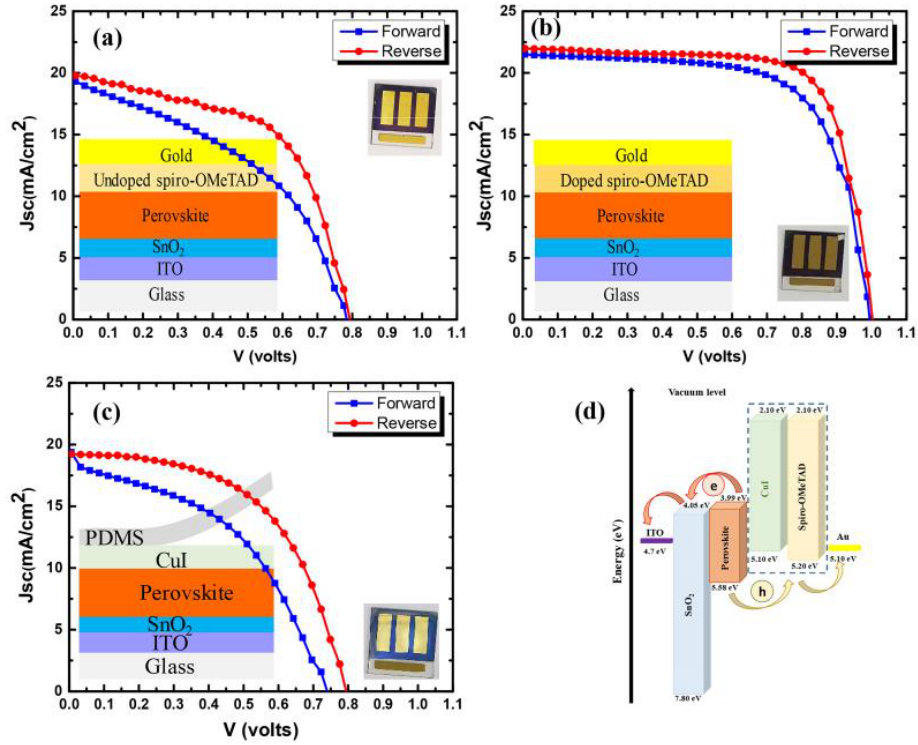
Figure 6. J–V curves for devices fabricated with different HTLs: ( a ) undoped spiro-OMeTAD, ( b ) doped spiro-OMeTAD, ( c ) transfer-printed CuI, ( d ) proposed charge transfer in the fabricated de- vices. Table 2. Device parameters for devices fabricated with different HTL materials.